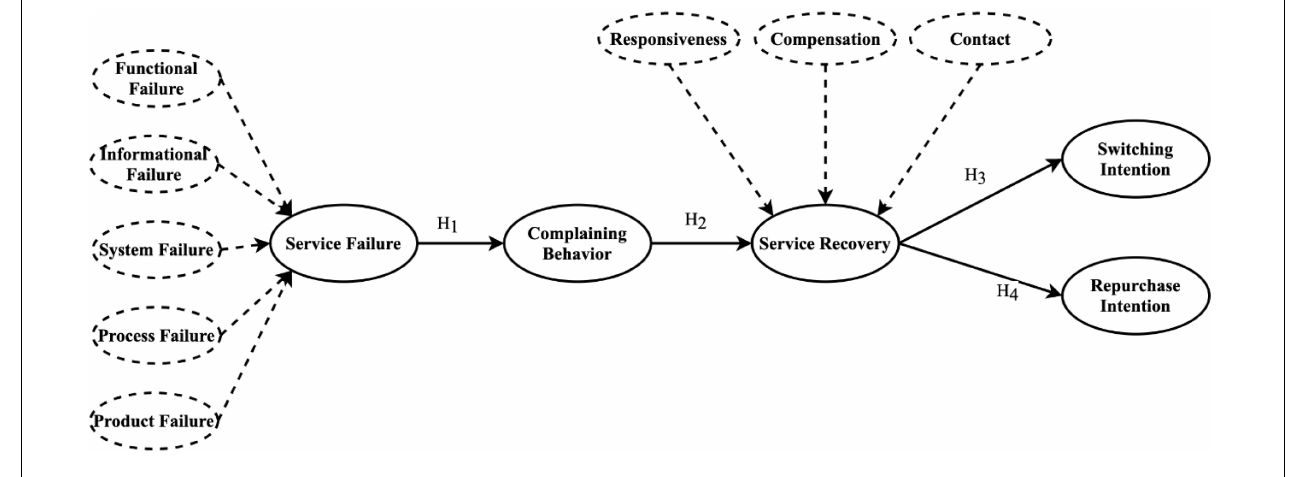
FIGURE 1 | Theoretical research framework.